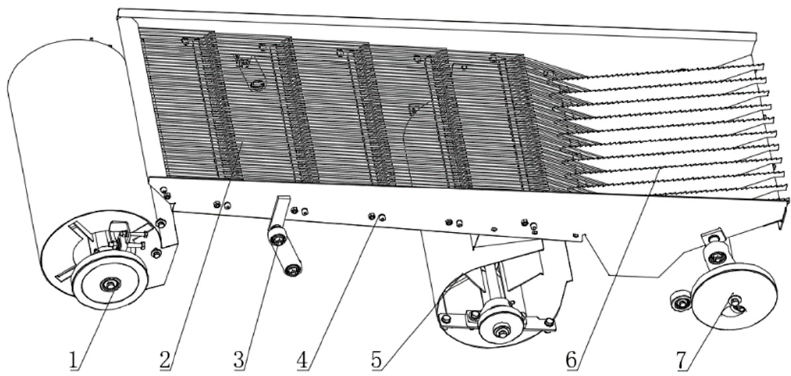
Figure 6. Sketch of the structure of the cleaning device. 1. Front fan; 2. vibrating bullet finger sieve plate; 3. pendulum; 4. vibrating screen frame; 5. rear fan; 6. straw walker; 7. eccentric wheel drive mechanism.